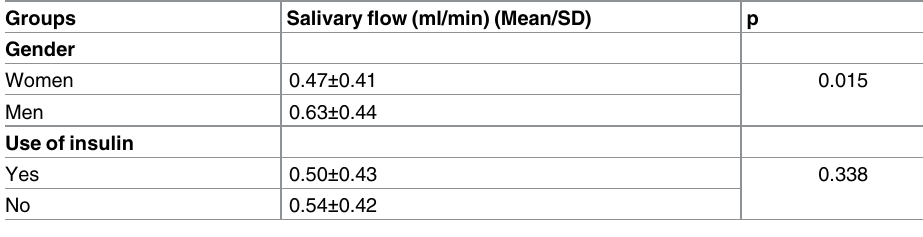
Table 1. Mean and standard deviation of salivary flow rate by gender and use of insulin.